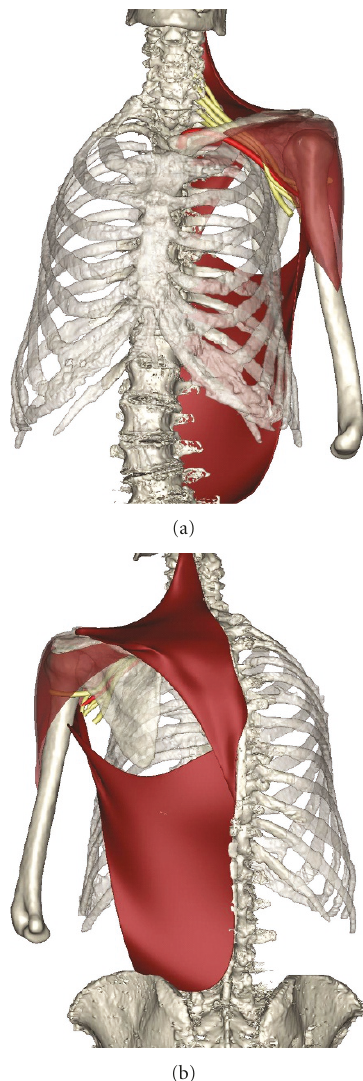
Figure 5: Front (a) and back (b) view of a partially reconstructed soft tissue model including the deltoid, latissimus dorsi and trapezius muscle, the subclavian artery and brachial